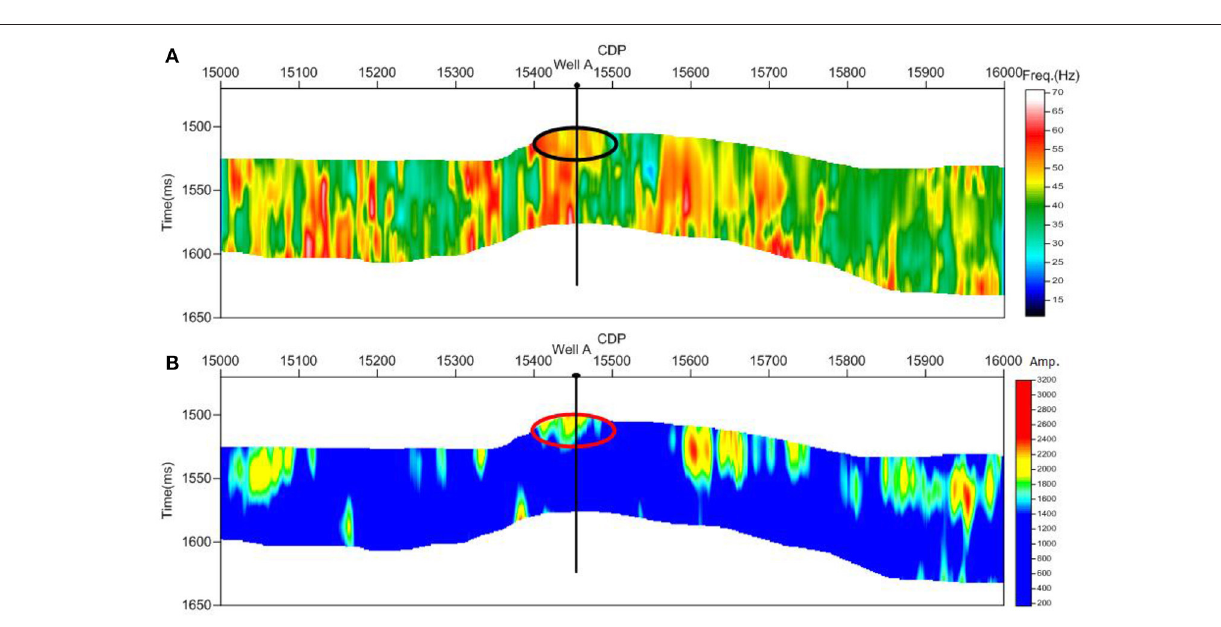
FIGURE 11 | The peak frequency volume and the maximum amplitude above the average amplitude volume extraction using the EMD-based wavelet ridge. (A) The peak frequency volume. (B) The maximum amplitude above the average amplitude